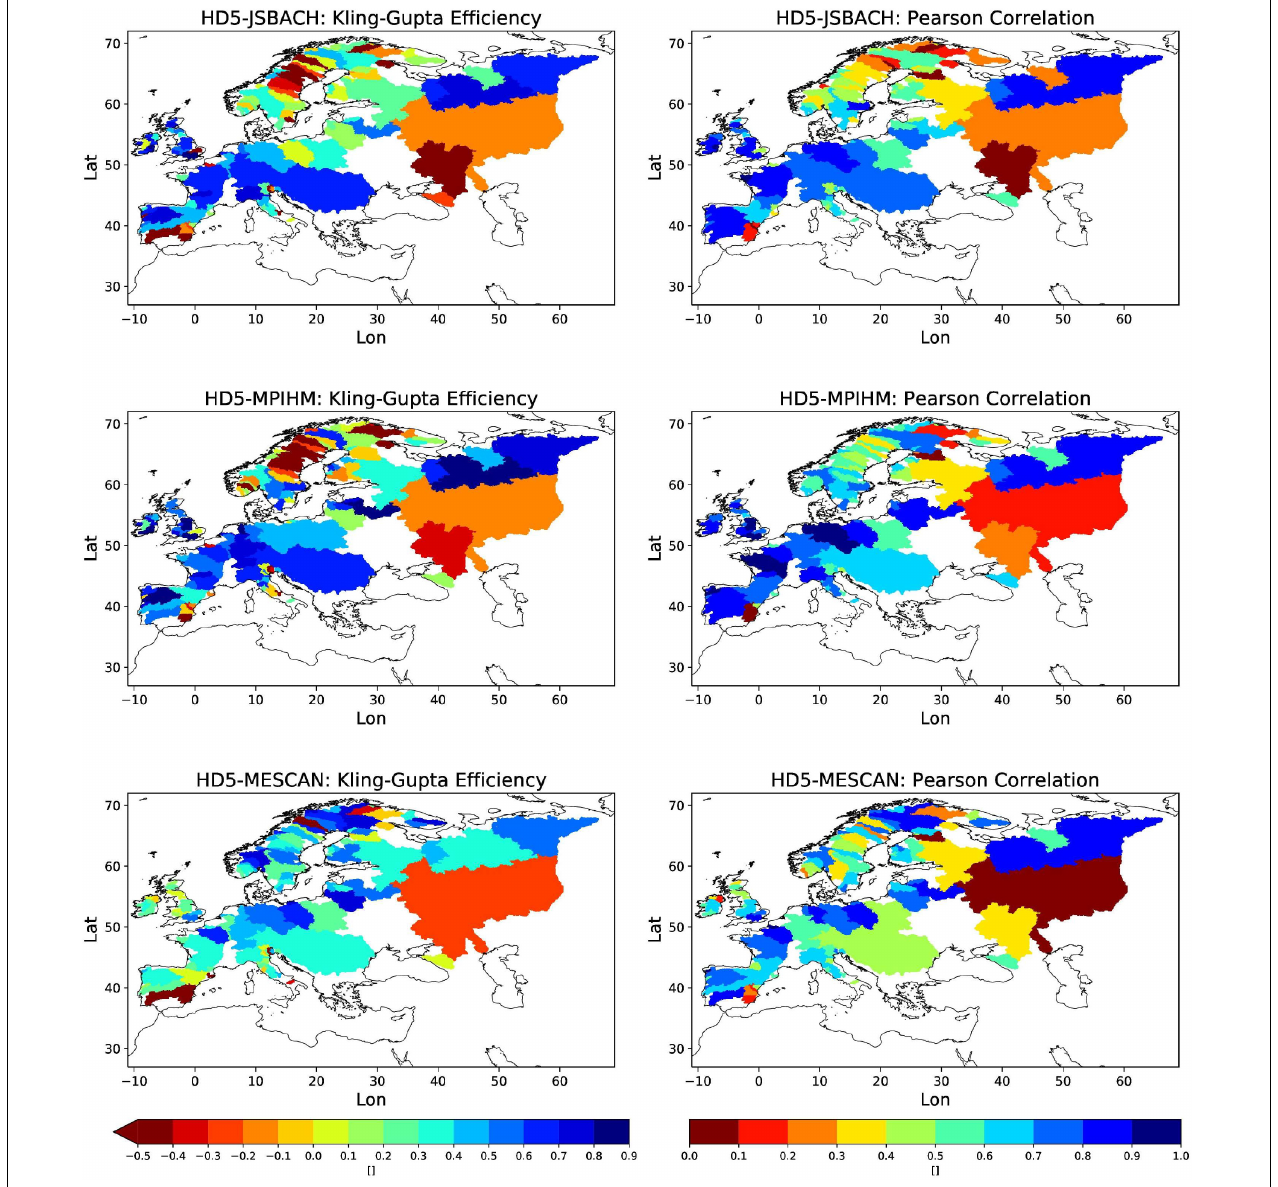
FIGURE 8 | Kling Gupta efficiencies (left column) and Pearson correlations (right column) with the observed daily discharges for HD5-JSBACH (1st row), HD5-MPIHM (2nd row), and HD5-MESCAN (3rd row).